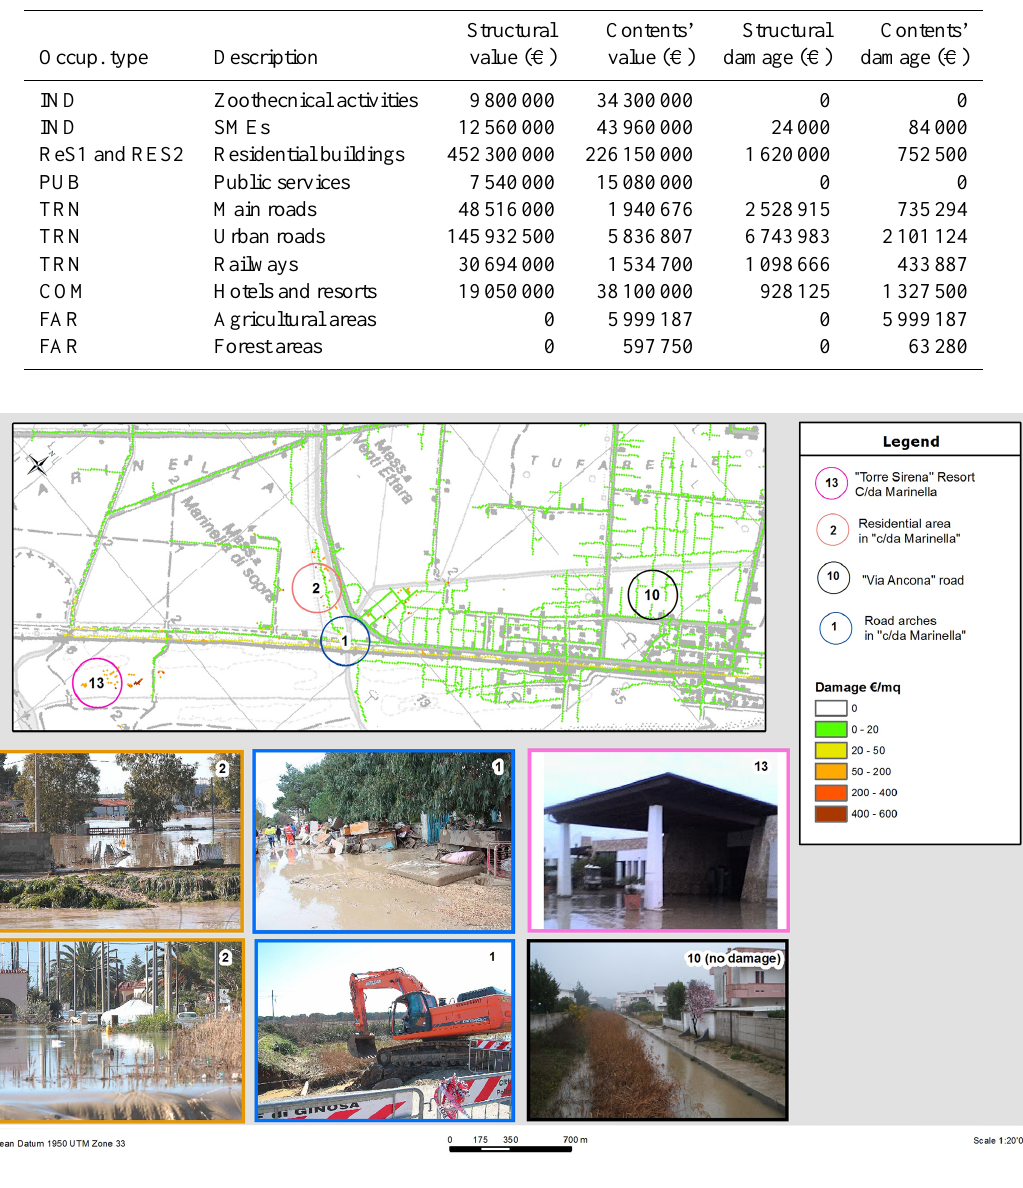
Figure 11. Direct damage